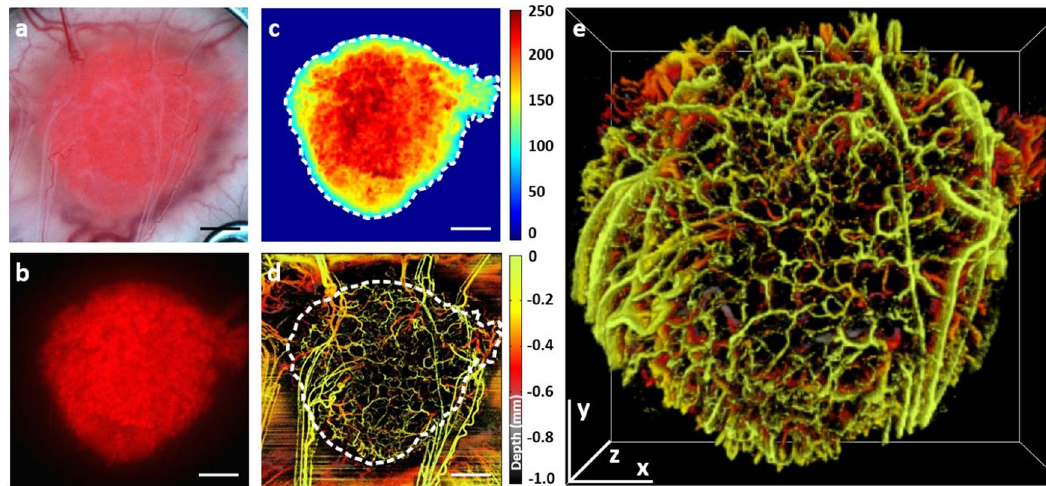
Figure 1. Tumour volume of interest (VOI) selection for the convolution neural network classifier implementation: ( a ) White light image of a fluorescently-labeled pancreatic adenocarcinoma tumour grown in a mouse dorsal skin window chamber; ( b ) Fluorescence image of the tumour shown in ( a ); ( c ) Tumour fluorescence image imported to red–green–blue (RGB, 256 gradations) colour space, thresholded and contoured using MATLAB software (threshold level equal to 77 out of 256); ( d ) Depth-encoded image of the corresponding 3D microvascular svOCT image co-registered with the fluorescence image contour in the en-face plane (white dashed curve, svOCT image is depth-encoded for better visual representation); ( e ) 3D tumour microvascular image generated from a 2D tumour mask projected from below the window chamber glass to the full image depth. Scale bars are 1 mm. Dose level (class) Mouse Time points (days)